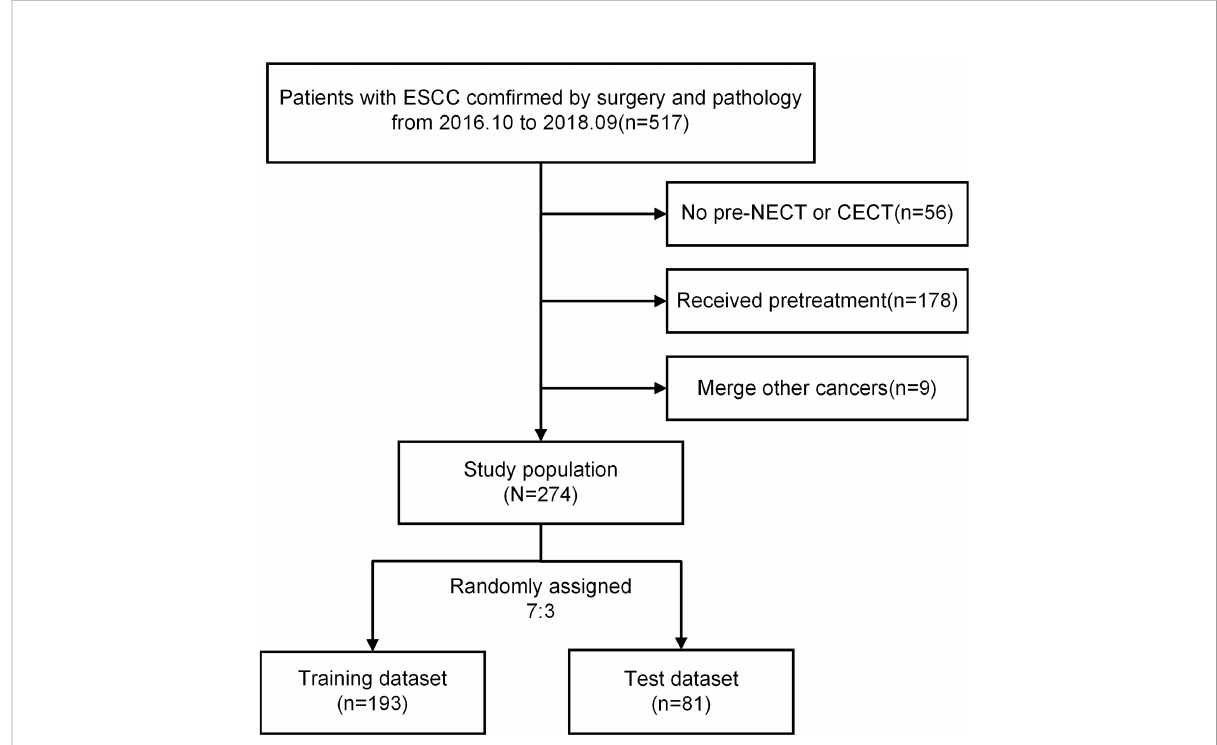
FIGURE 1 Flowchart of the exclusion and inclusion processes. ESCC, esophageal squamous cell carcinoma; NECT, non-contrast-enhanced computed tomography; CECT, contrast-enhanced computed